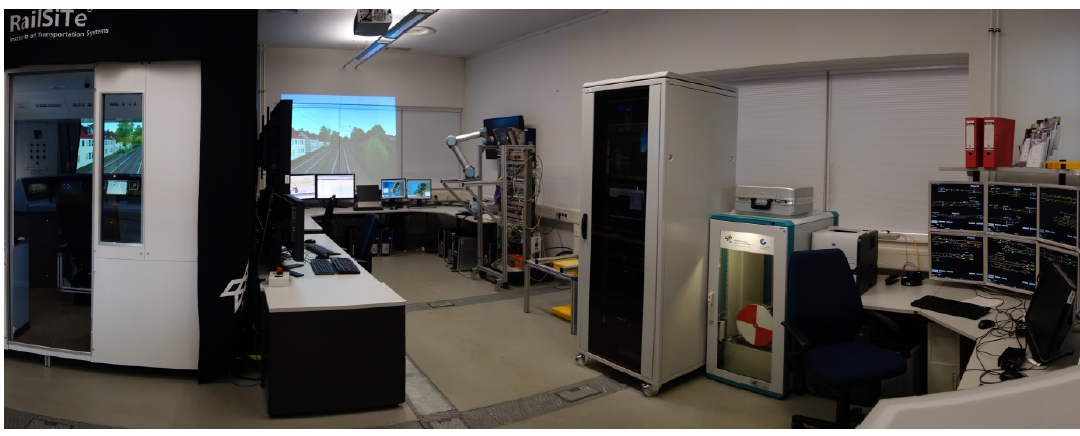
Figure 1: RailSiTe® simulation and testing